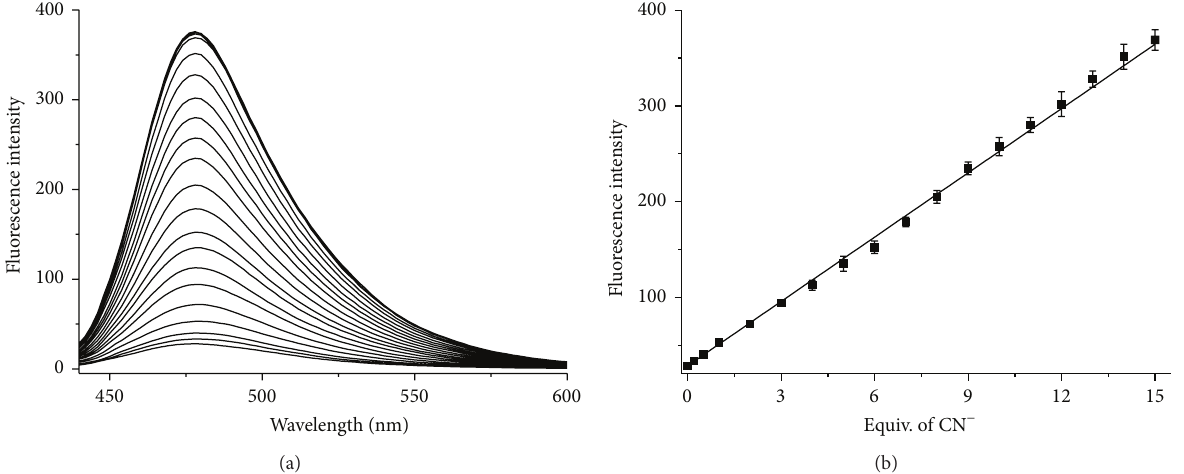
Figure 4: (a) Fluorescence titration of C -GGH-Cu 2+ (1.0 𝜇 mol/L) with CN − (0–30equiv., 0.0, 0.2, 0.5, 2.0, 3.0, 4.0, 5.0, 6.0, 7.0, 8.0, 9.0, 10.0, 11.0, 12.0, 13.0, 14.0, 15.0, 20.0, 25.0, and 30.0 𝜇 mol/L, resp.) in HEPES aqueous buffer (10mmol/L, pH 10.0). (b) Dose-dependent luminescence response of C -GGH-Cu 2+ (1.0 𝜇 mol/L) to CN −